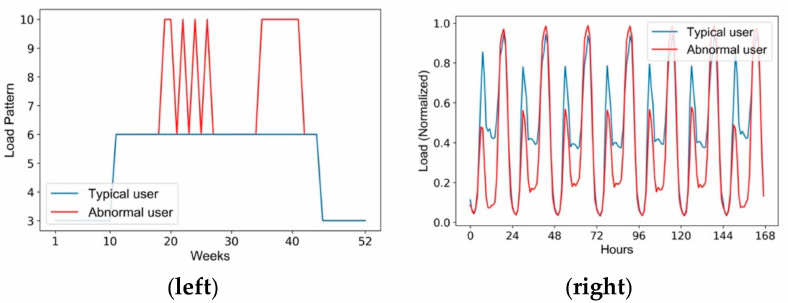
Figure 16. The impact of climate zones on Hotel users of Illinois and Florida with user behavior ( left ) and load patterns ( right